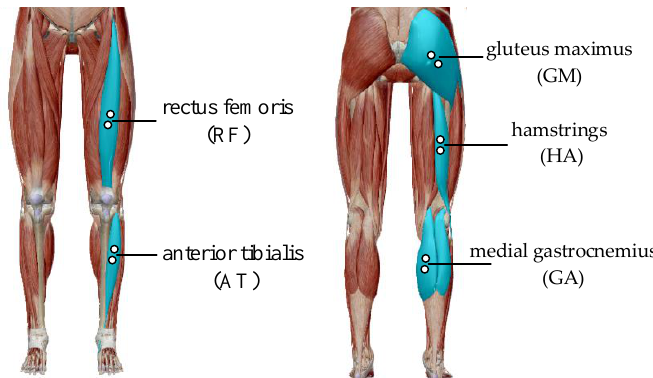
Figure 1. The schematic diagram of the human lower limb muscles in this study. The position of the two white points on one muscle represented the position of the electromyographic (EMG) electrodes attached.